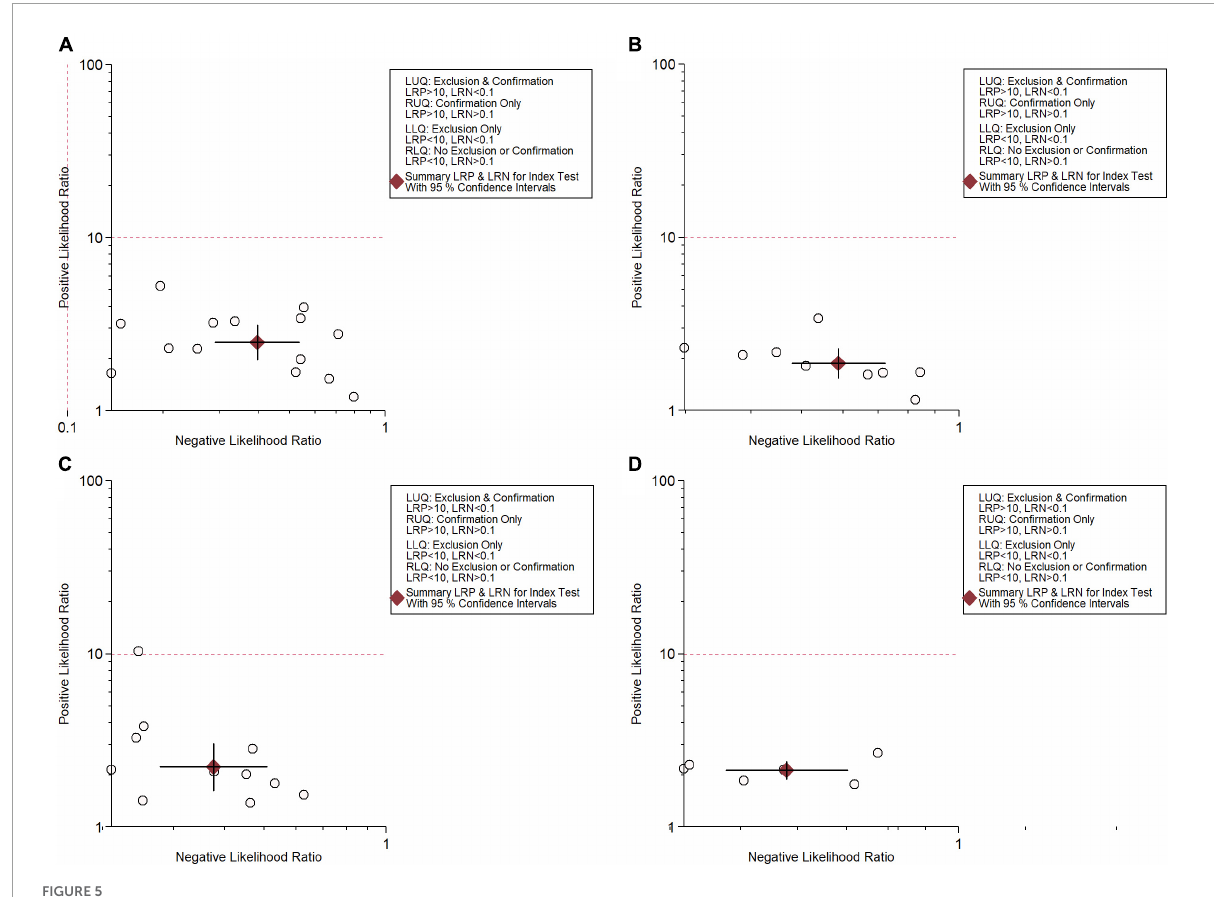
FIGURE5 LR scattergram (A) NLR; (B) PLR; (C) CRP; (D) NLR and PLR